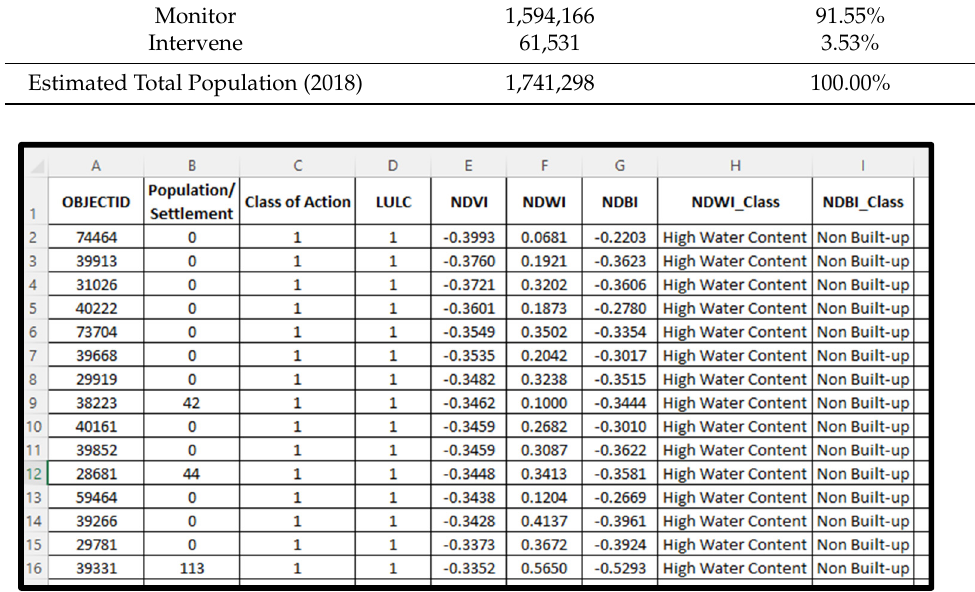
Figure 16. Excel Sheet of the superimposed IUHI Class with Population/Settlement Data. Table 17. Distribution of affected population per IUHI class of